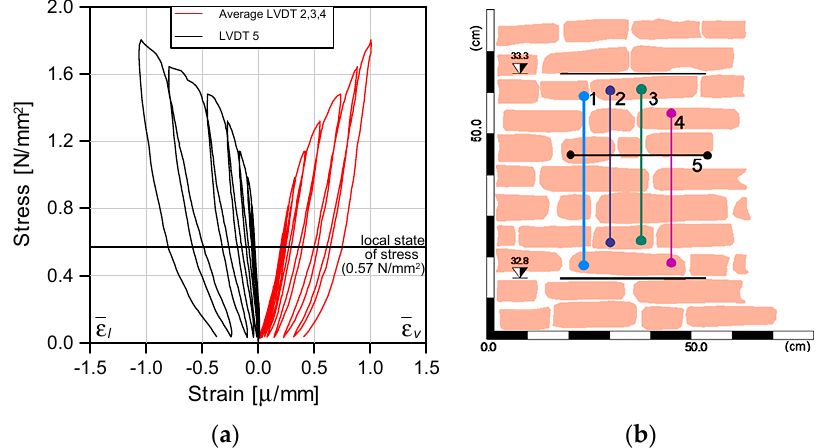
Figure 14. Results of the double flat jack test ( a ) and ( b ) survey superficial texture of the investigated area [15].